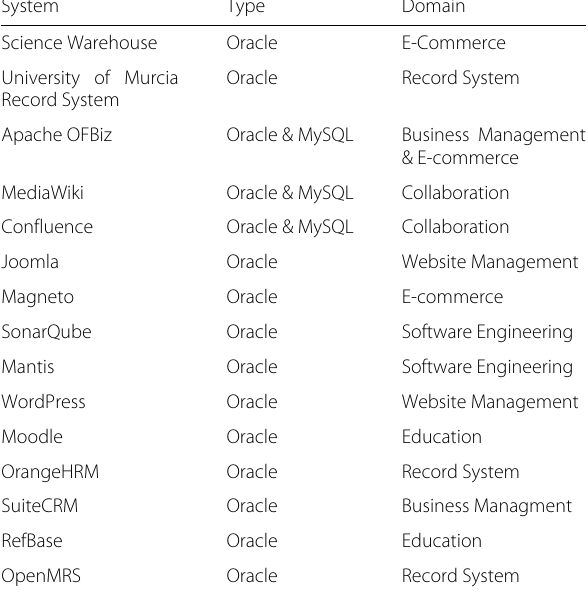
Table 1 Database schemas used for keyword